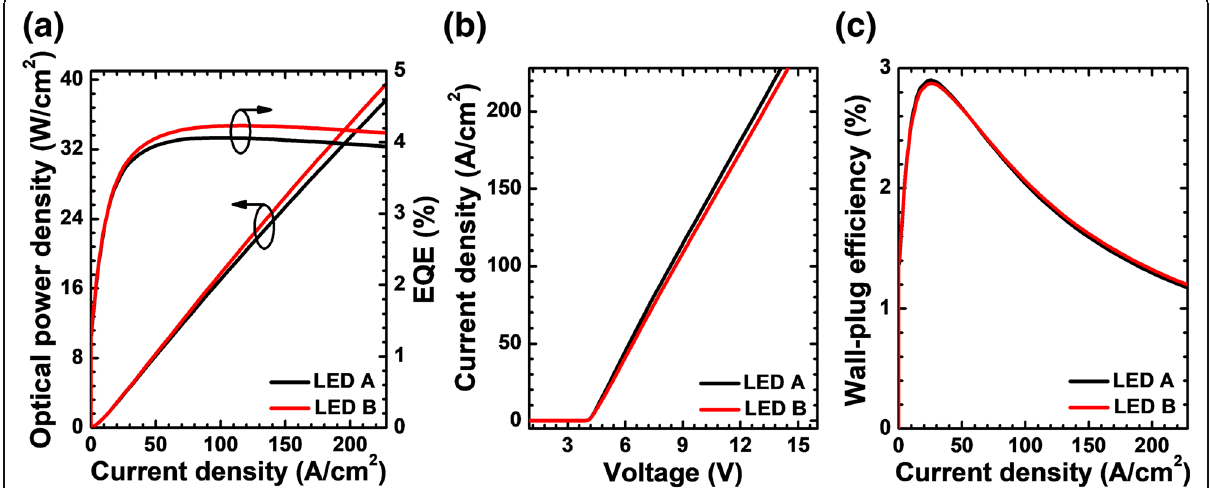
Fig. 5 a EQE and optical power density in terms of the injection current, b current-voltage characteristic, and c WPE as a function of the injection current for LEDs A and B